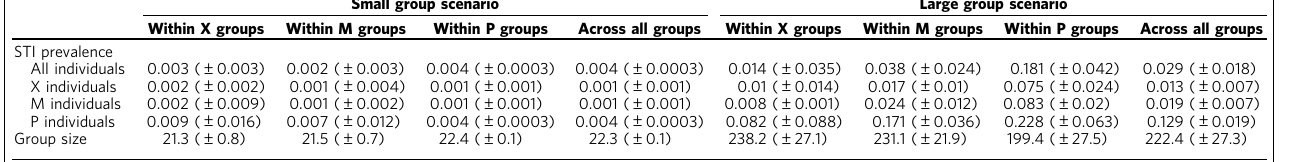
Table 2 | STI prevalence and group size by